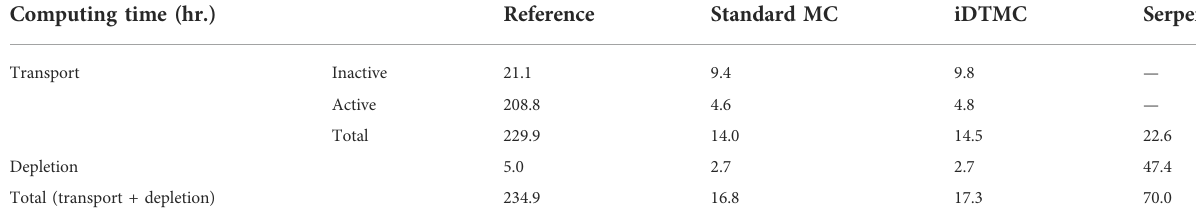
TABLE 2 Total computing time for the whole core depletion calculation. Computing time (hr.)